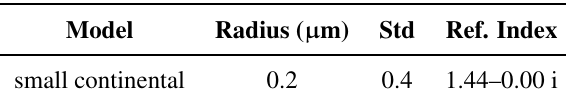
Table 3. Aerosol model used in the